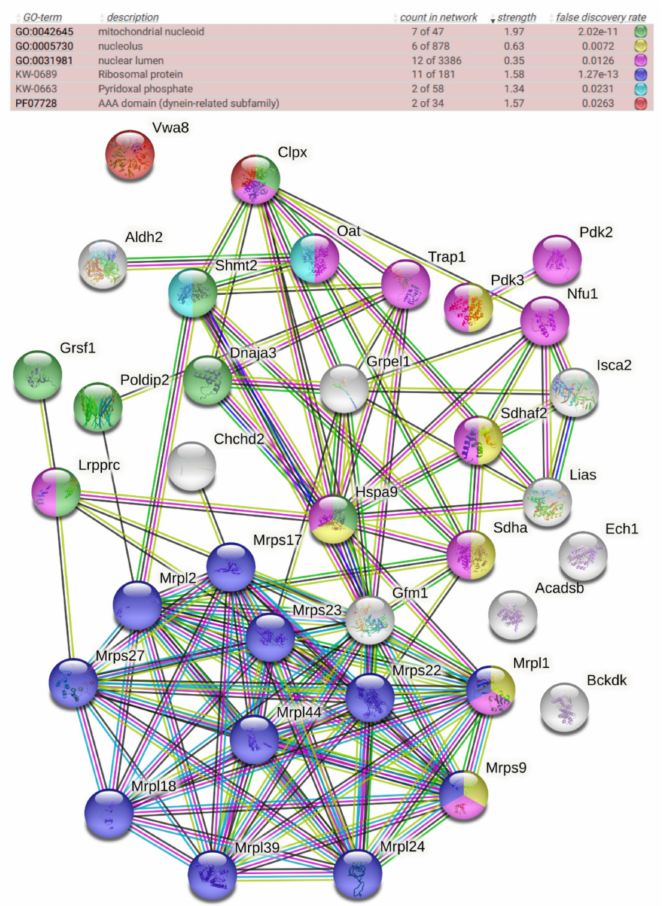
Figure 2. STRING protein–protein interaction diagram of significantly upregulated factors, consistent among the global proteomes of MEFs, brain supernatants, and brain pellet fractions. The color of each factor and the significance of enrichment are detailed above the diagram, showing its implication in functional contexts. The color of lines between factors reflects the degree of known